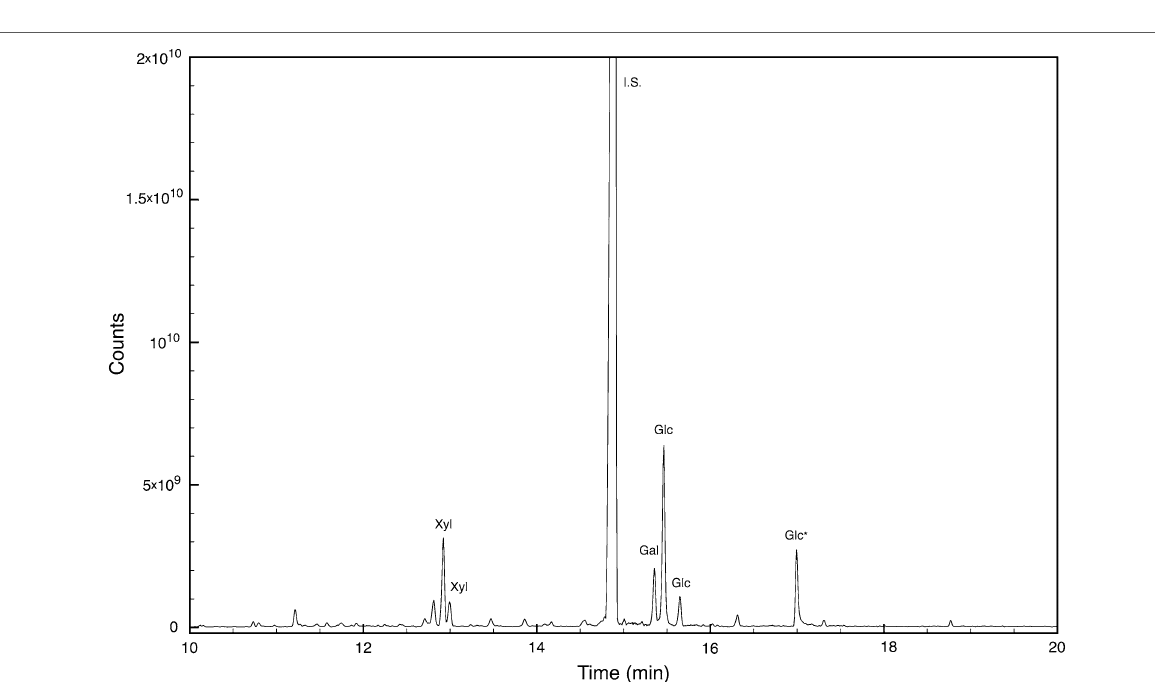
Fig. 8 GCMS chromatogram showing the carbohydrate content of P. septica OOWS-10 supernatant fraction having emulsifying activity after microwave assisted acid